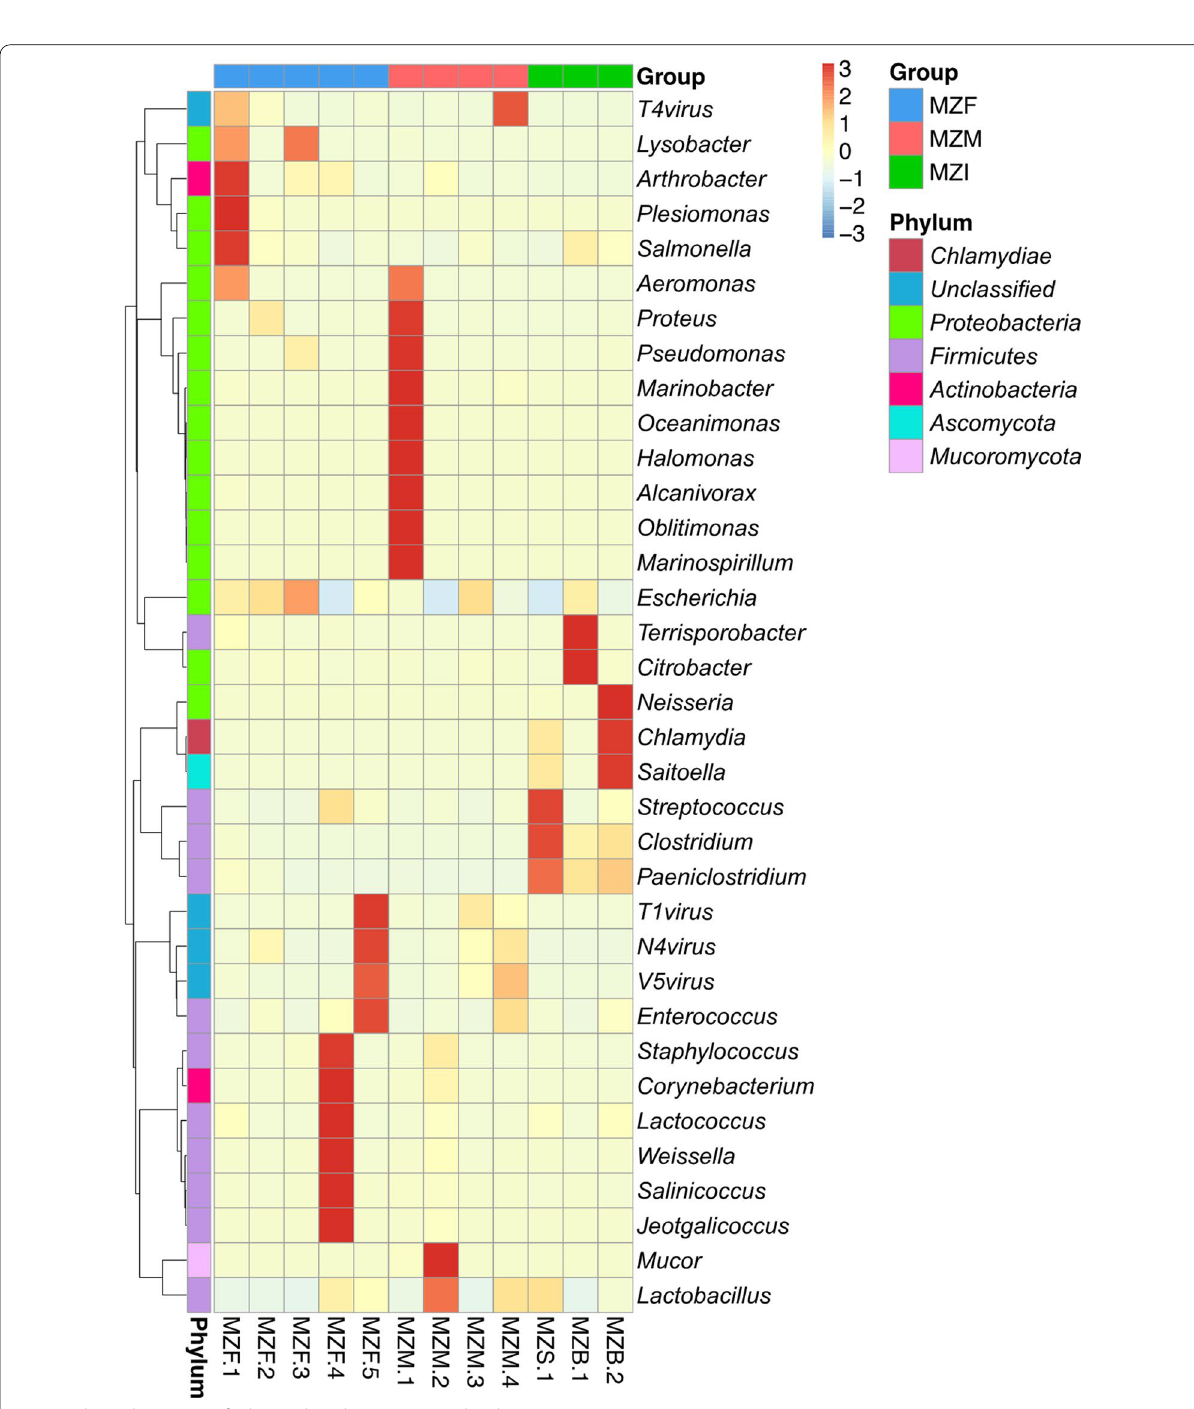
Fig. 1 Cluster heat map of relative abundance at genus